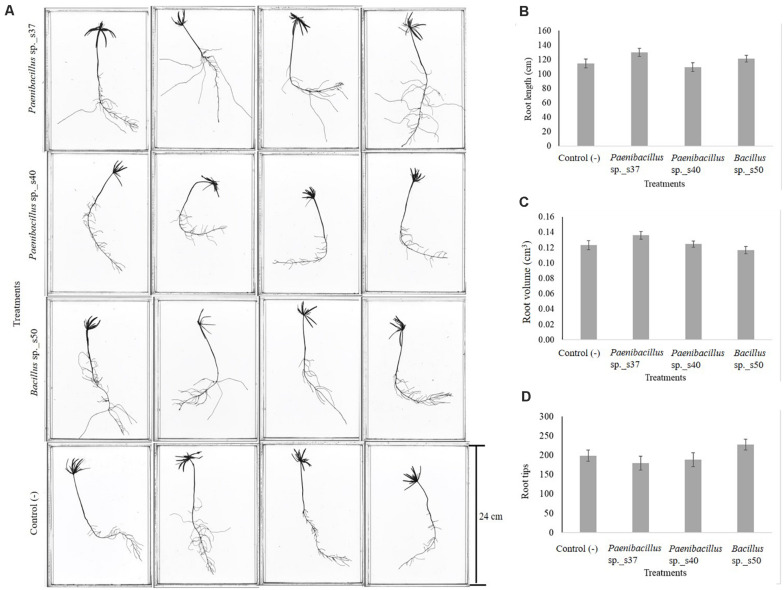
Effect of selected root-associated bacterial strains on growth of A. nordmanniana under greenhouse conditions. Seeds were inoculated with bacterial cell suspensions and sowed pots with non-sterilized soil, which were kept at the greenhouse at 18°C for 30 days. After 30 days of growth, the seedlings were scanned (A) and measured for root length (cm) (B), root volume (cm3) (C), and number of root tips (D). The figure shows the average values of six replicates per treatment. Each bar represents the Standard Error.